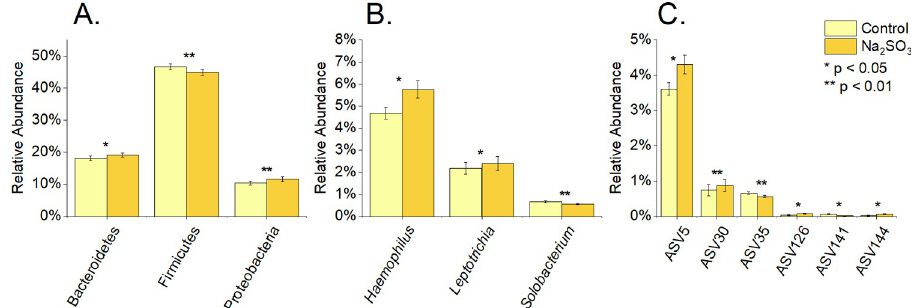
Fig 6. Differentially abundant bacteria at different taxonomic levels in F2 sample, after sodium sulfite treatment at time 0. 16S rRNA sequencing was used to determine the % relative abundance of phyla (A), genus (B), and ASV (C) for control and treated samples with Na 2 SO 3 . P values were calculated using paired t-tests.